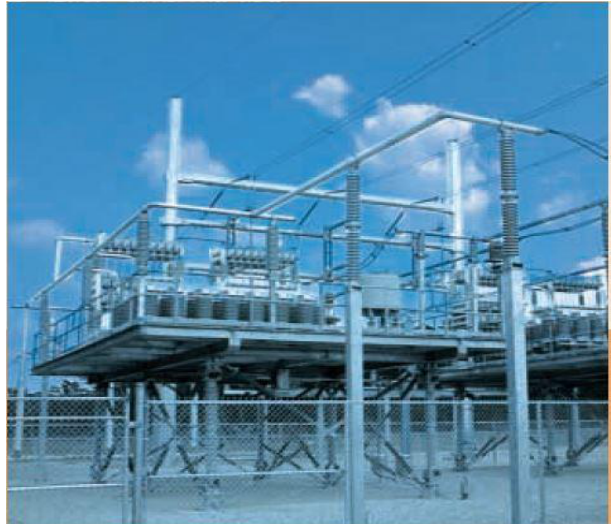
Figure 1. Series Capacitor compensation (70%) in the